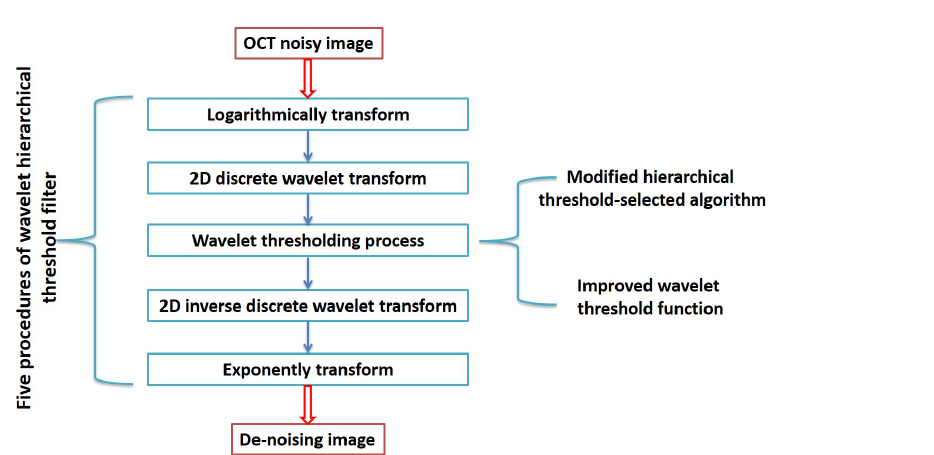
Fig. 2. Procedure of improved wavelet hierarchical threshold de-noising for OCT